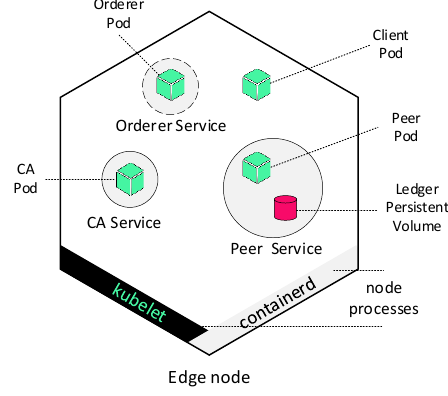
Fig. 2. HLF components Kubernetes deployment